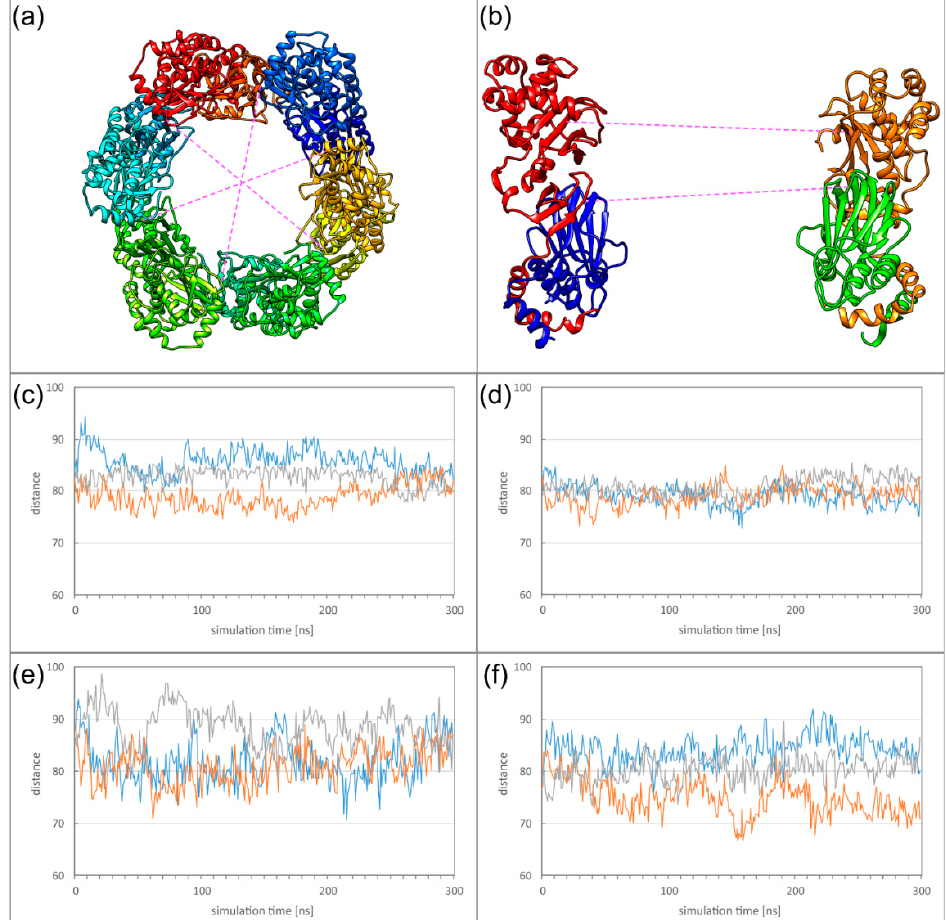
Figure 9. ( a ) Schematic presentation showing between which subunits ring deformation was measured. ( b ) Side view on two subunits located on opposite sides of the Hexagon. The distances analysed for global deformation (lower dotted line) and pUL53 (pUL31) flexibility (upper dotted line) are indicated. ( c – f ) The diagrams display the overall deformation of the ring for HCMV ( c ) and HSV ‐ 1, ( d ) as well as the flexibility of the pUL53 (pUL31) subdomains for HCMV ( e ) and HSV ‐ 1 ( f ).